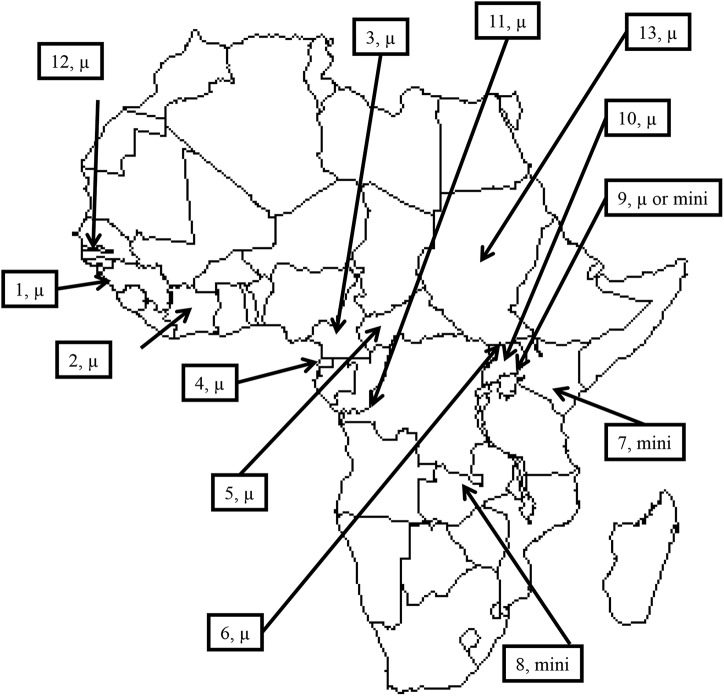
Location of different samples of trypanosomes reanalyzed with population genetics tools for estimating population parameters.1: Boffa and Dubréka (Guinea) HAT foci. Strains were isolated (I) [12] or directly amplified (D) [28]. 2: Bonon HAT focus (I) (Ivory Coast) [12]. 3: Campo, Bipindi, and Fontem HAT foci (Cameroon), (I) [23], (D) [36], 4: Mbini and Kogo HAT foci (Equatorial Guinea), (I) [23]. 5: Batangafo and Obo HAT foci (Central African Republic), (I) [23]. 6: Omougou HAT foci (Uganda), (I) [23]. 7: Nyanza HAT focus (Kenya), (I) [22,37]. 8: Luangwa HAT focus (Zambia), (I) [22,37]. 9: Busoga HAT focus (Uganda), (I) [22,37], (D) [38]. 10: Soroti HAT focus (Uganda), (D) [38]; 11. Maluku HAT foci (DRC), (D) [36]. 12: Nagana area of Central River District (The Gambia), (D) [5,7]. 13: Surra area of Darfour, Kurdofan, Kassala, Halfa and Showak (Sudan), (D) [39]. μ: Microsatellite genotyping; mini: minisatellite genotyping.